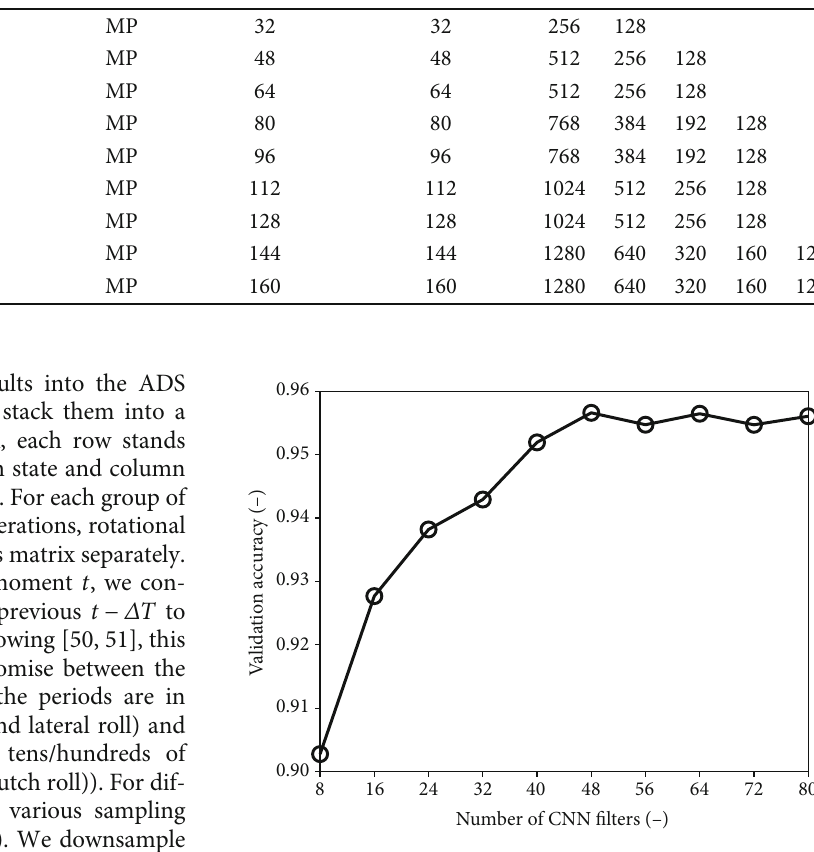
Figure 8: Training outcomes of DNN-K2 (with 64 CNN fi lters) and other 9 descendant architectures (Table 6); horizontal axis indicates the number of CNN fi lters enclosed in the fi rst convolutional layer.